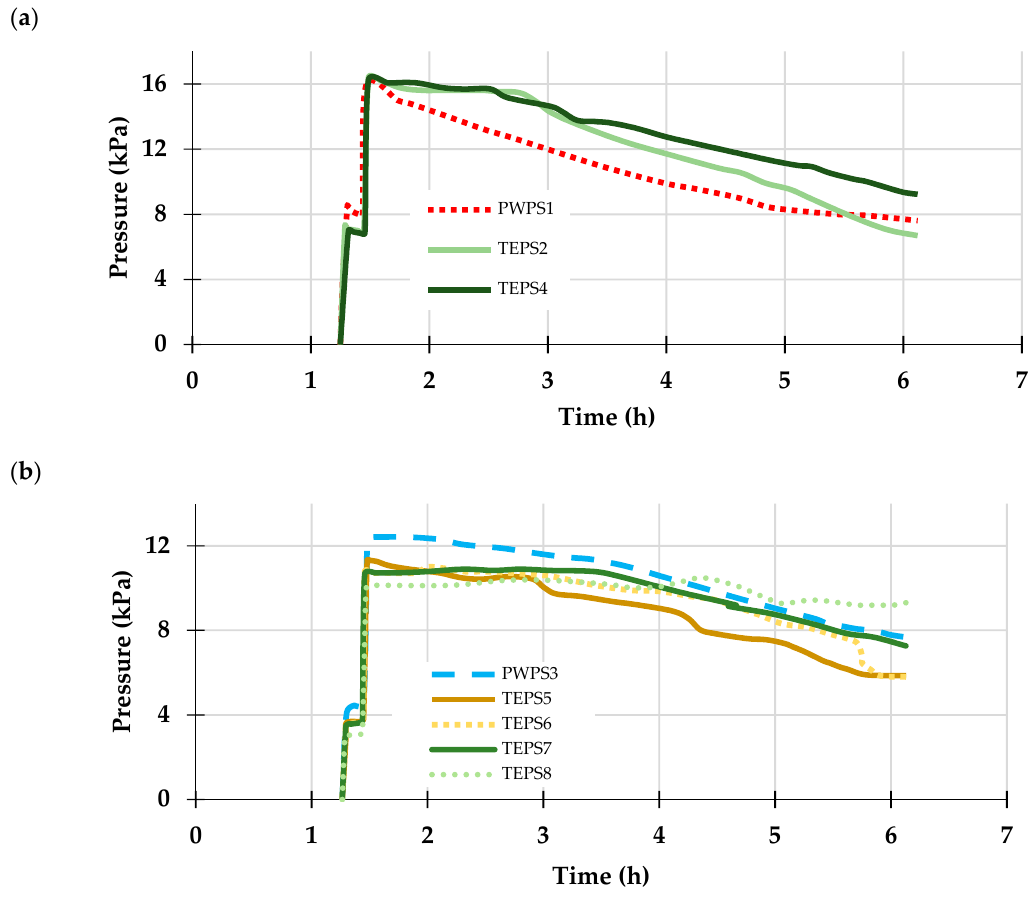
Figure 12. Backfill pressure measurement: ( a ) at the base of the stope, and ( b ) at 20 cm above the base of the stope.